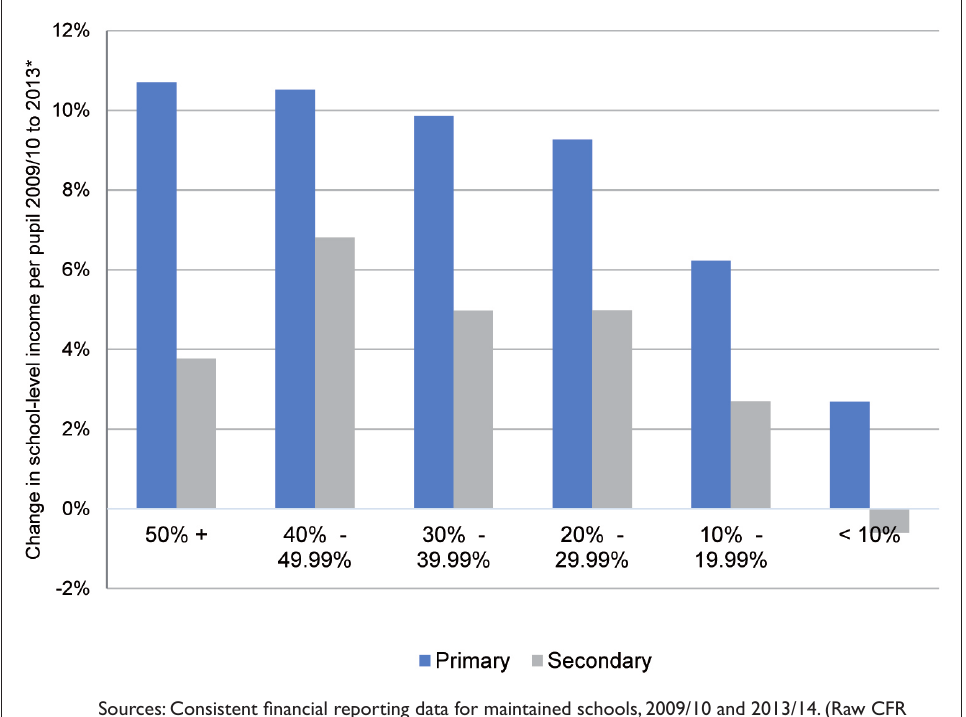
Figure 1: Changes in school-level income per pupil 2009/10 to 2013/14 (real terms 2009/10 prices), by FSM band (excluding